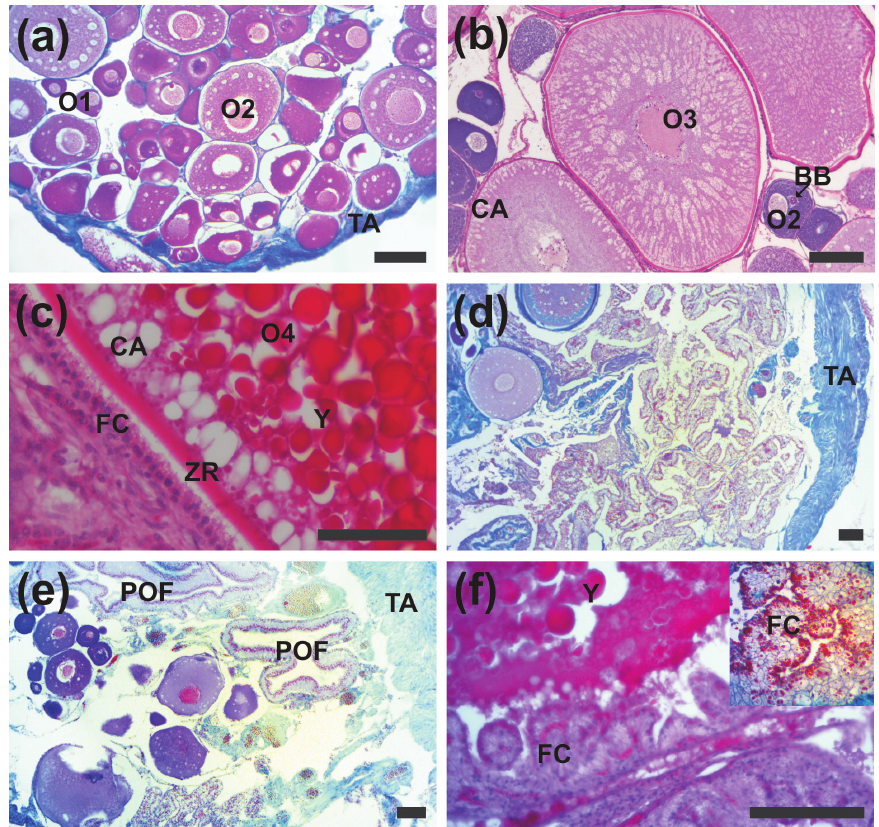
Figure 3 - Histological sections of H. francisci ovaries stained with hematoxylin-eosin and Gomori´s thricrome. (a) ovarie in regenerating stage, with perinucleolar oocytes (O1 and O2), Note the thin ovarian tunica albuginea (TA). (b) initial previtelogenic oocyte (O3) and perinucleolar advanced (O2) with Balbiani´s Body (BB). (c) vitellogenic oocyte (O4) with the cytoplasm rich in yolk globules (Y), zona radiata (ZR), cortical alveoli (CA). (d) ovary in regressing stage with a thick tunica albuginea (TA). (e) postovulatory follicle (POF) with prismatic cells and large lumen. Note the thick tunica albuginea. (f) atretic follicles (AF), with liquefied yolk (Y), prismatic follicular cells (FC). Insert evidenced the yolk reabsorption in follicular cells (FC). Bars: 100